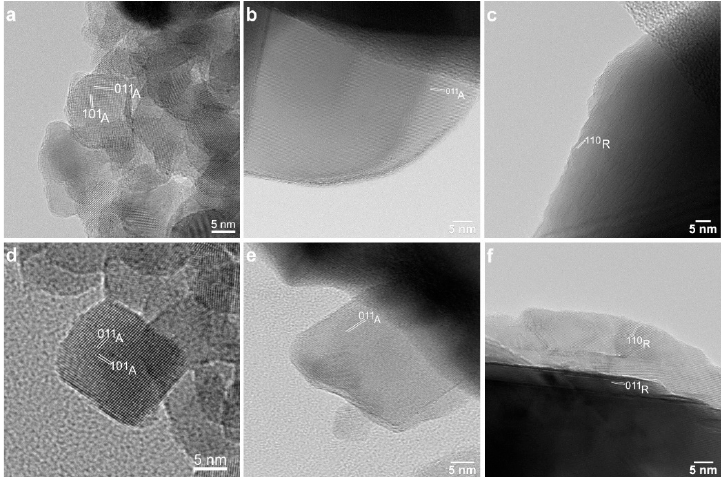
Figure 4. HRTEM images of the ( a ) T400W, ( b ) T550W, ( c ) T800W, ( d ) T400B, ( e ) T550B, and ( f ) T800B samples. Interplanar distances are marked for the anatase ( a , b , d , e ) and rutile ( c , f ) phases.